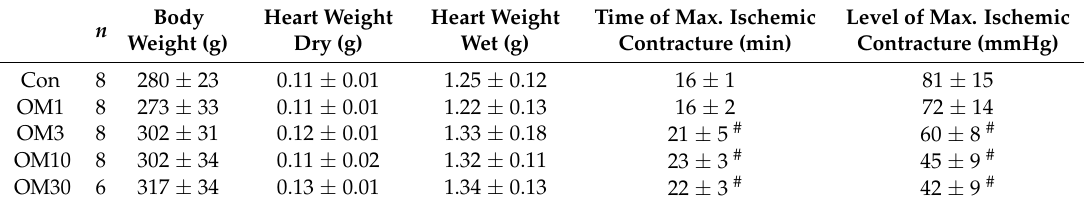
Table 1. Weights and ischemic contracture.